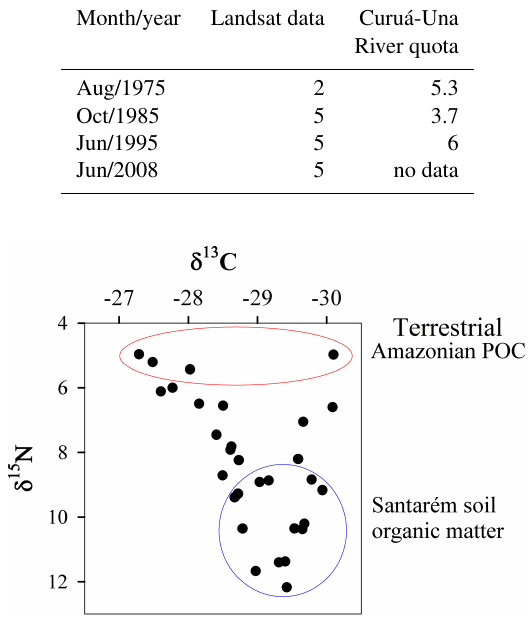
Figure 5. δ 13 C vs. δ 15 N. The Amazon River POC and Santarém soil organic matter values, adjacent to the study area, are taken from Zocatelli et al.